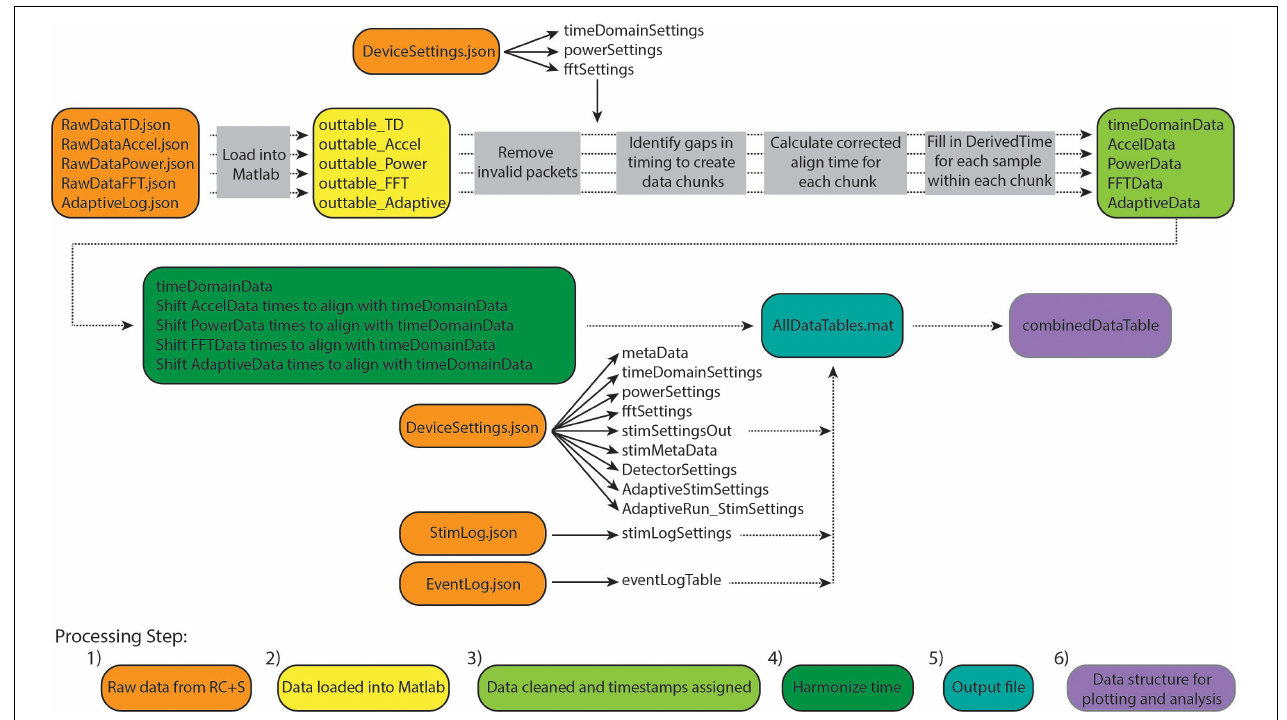
FIGURE 2 | Overview of Summit RC+S data parsing and time alignment. Raw JSON files (orange) are loaded into Matlab (yellow). For each time series data stream, packets with invalid data are removed and timing variables are used to calculate DerivedTime for each sample (light green). Samples in each data stream are aligned to DerivedTime for time domain data, which has the highest sampling rate (dark green). These data tables are saved in a.mat file (using a combination of tables and sparse matrices) along with tables containing settings information and metadata (blue). Finally, combinedDataTable is created which can be used for plotting and user-specific analyses